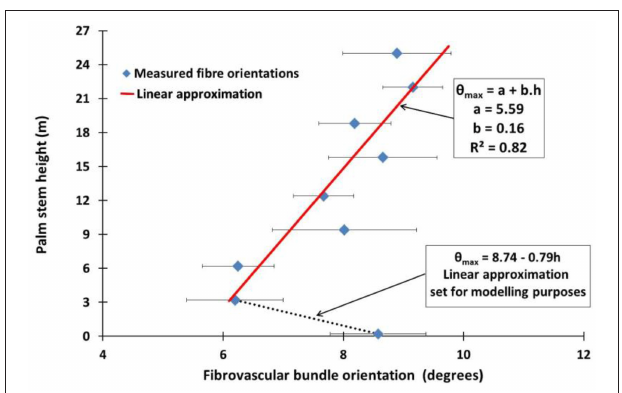
TABLE 5 | Average values of natural frequencies at all investigated heights and the representative natural frequency f for all the studied cocowood discs.